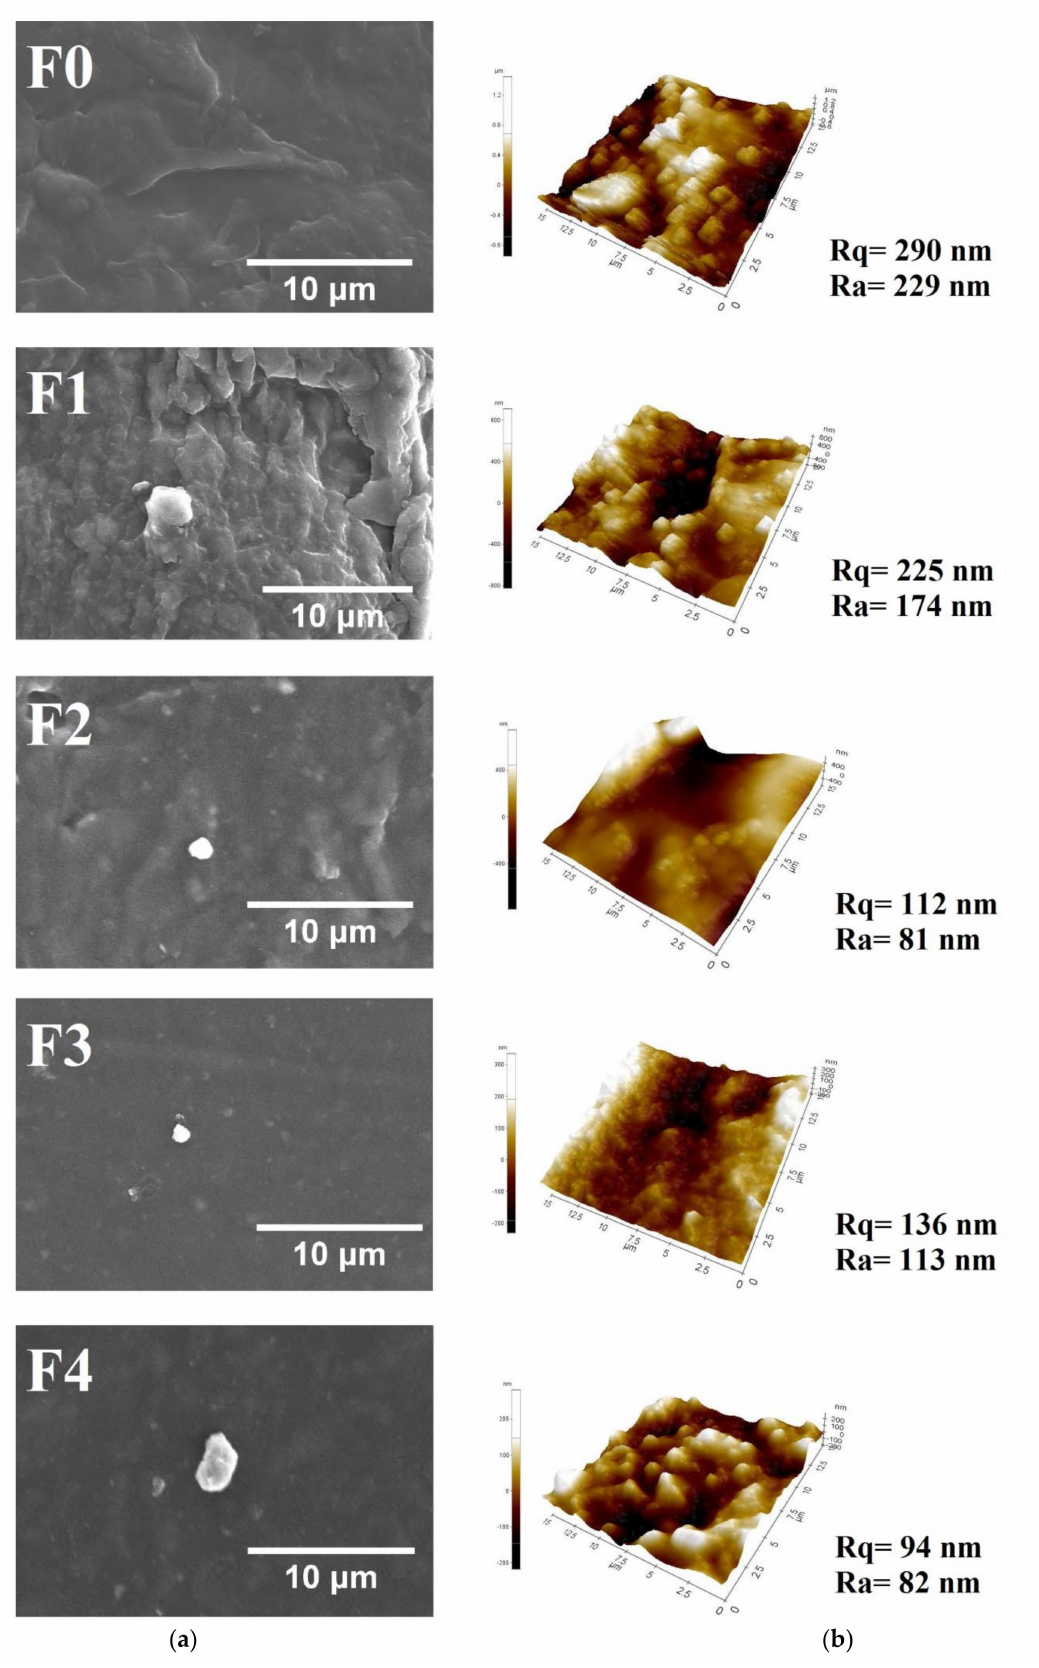
Figure 2. SEM images ( a ) and AFM images ( b ) of the bionanocomposite and control